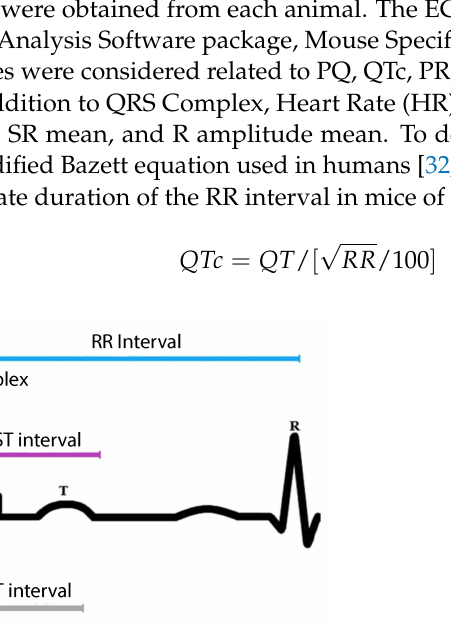
Figure 1. The P wave (atrial depolarization) and QRS complex (ventricular depolarization); PQ interval (beginning of the P wave to the beginning of the QRS complex); PR interval (beginning of the P wave to the peak of the QRS complex); ST interval (ventricular repolarization); QT interval (ventricular depolarization and repolarization); and RR interval (time between ventricular depolarization peak). SR (mean amplitude of the signal measured from each signal minimum (S) line to the peak of the